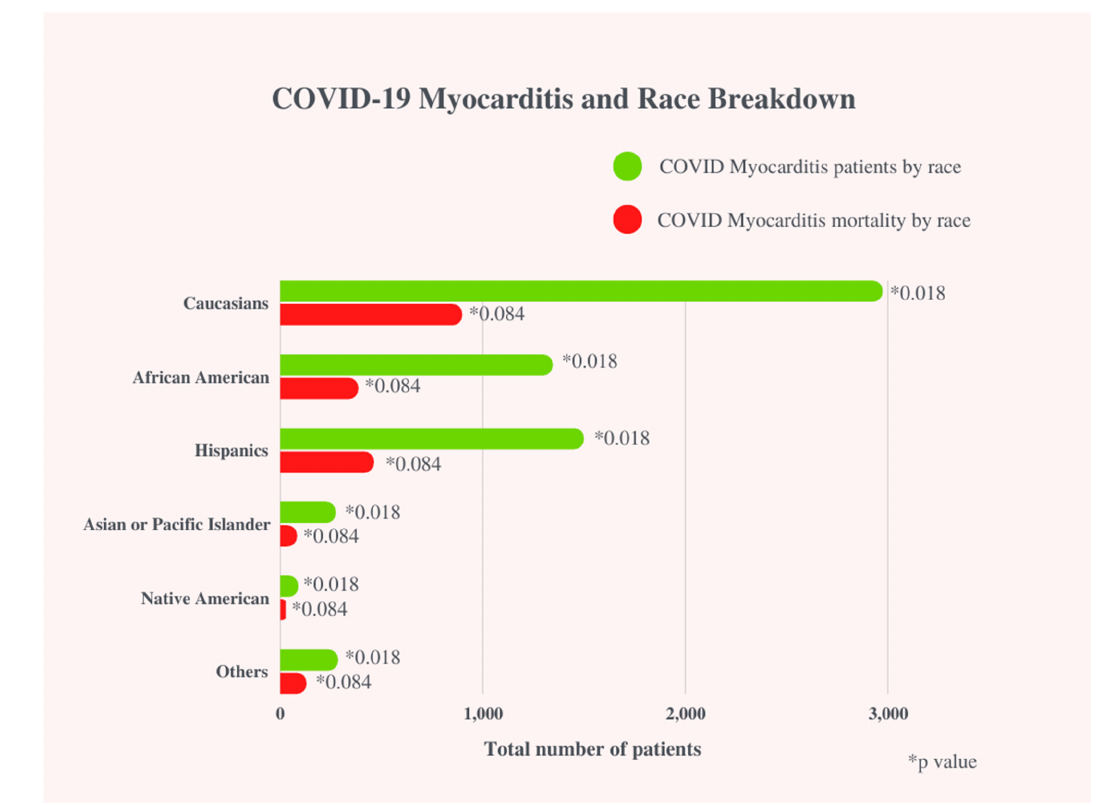
Viruses 2022 , 14 , x FOR PEER REVIEW